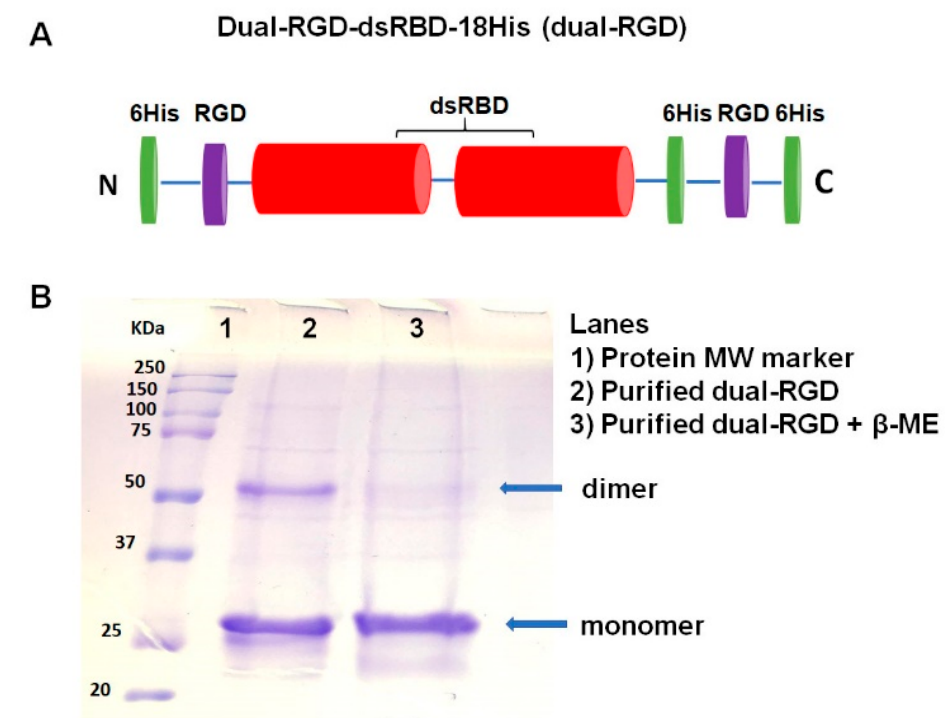
Figure 1. Cloning and production of dual-RGD-dsRBD-18H (dual-RGD) protein. ( A ) Schematic illustration of dual-RGD protein structure. ( B ) SDS-PAGE analysis of dual-RGD protein. Dual-RGD protein is shown as a monomer (26 KDa) and a dimer (52 KDa) in nonreducing conditions (lane 2) and a single monomer under reducing (lane 3) conditions.